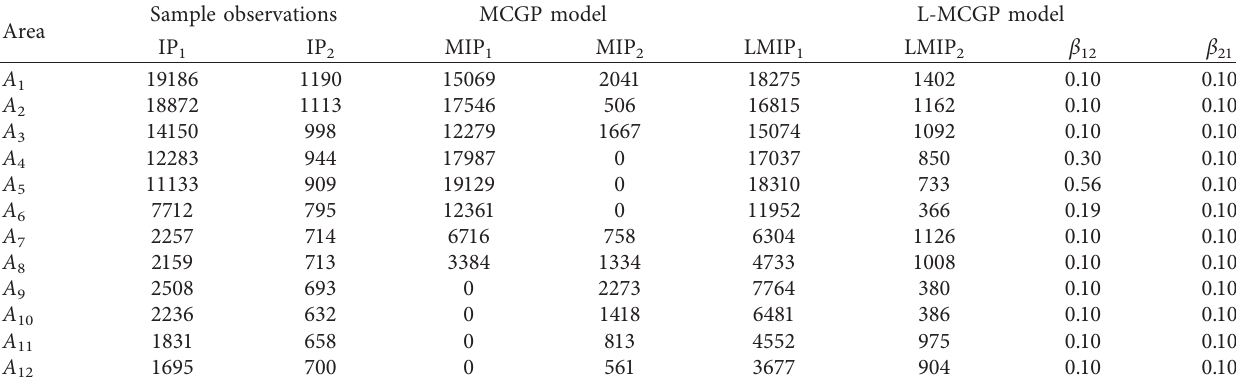
Table 4: Solution of the MCGP